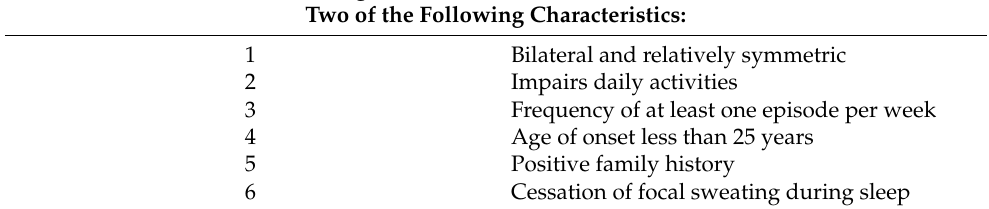
Table 1. Criteria for establishing PFH as recommended by Hornberger et al. [40]. Focal, Visible, Excessive Sweating of at Least 6 Months Duration Without Cause with at Least